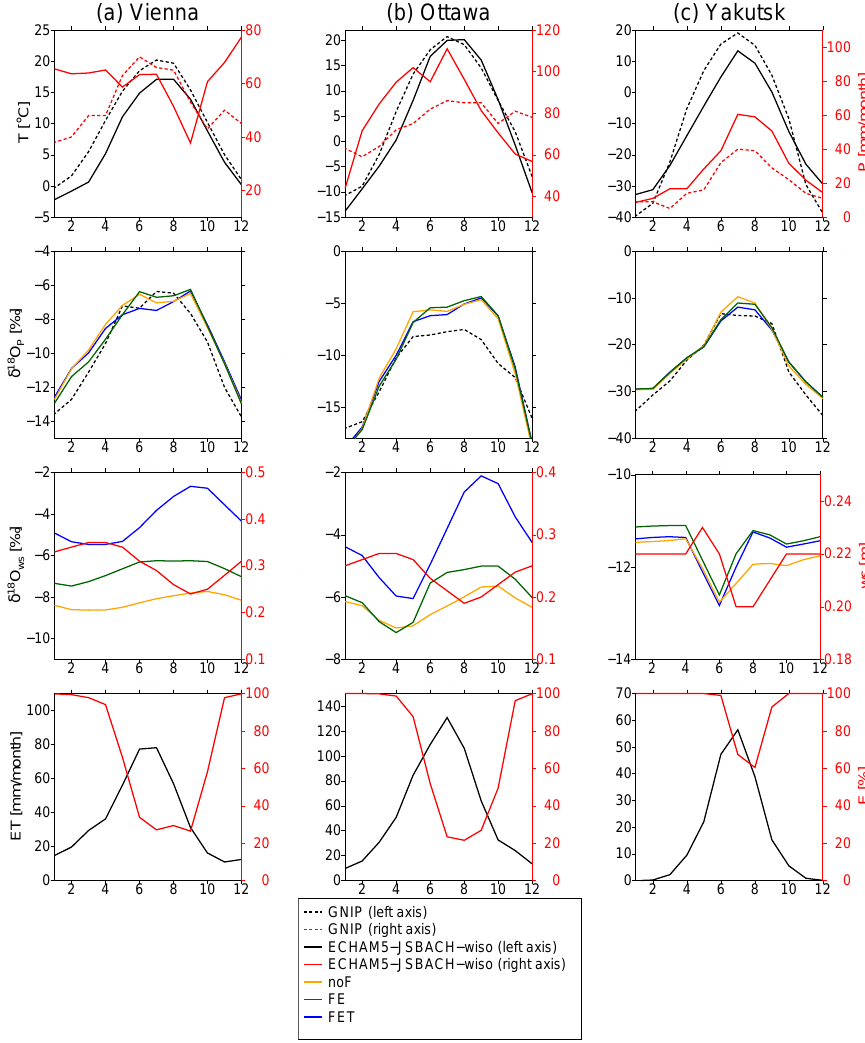
Fig. 11. As Fig. 10 but for the locations (a) Vienna, (b) Ottawa, and (c) Yakutsk. Fig. 11. As figure 10, but for the locations (a) Vienna, (b) Ottawa, and (c) Yakutsk. in the upper soil layers, while water in deeper soil layers, which can be used for plant transpiration, is more